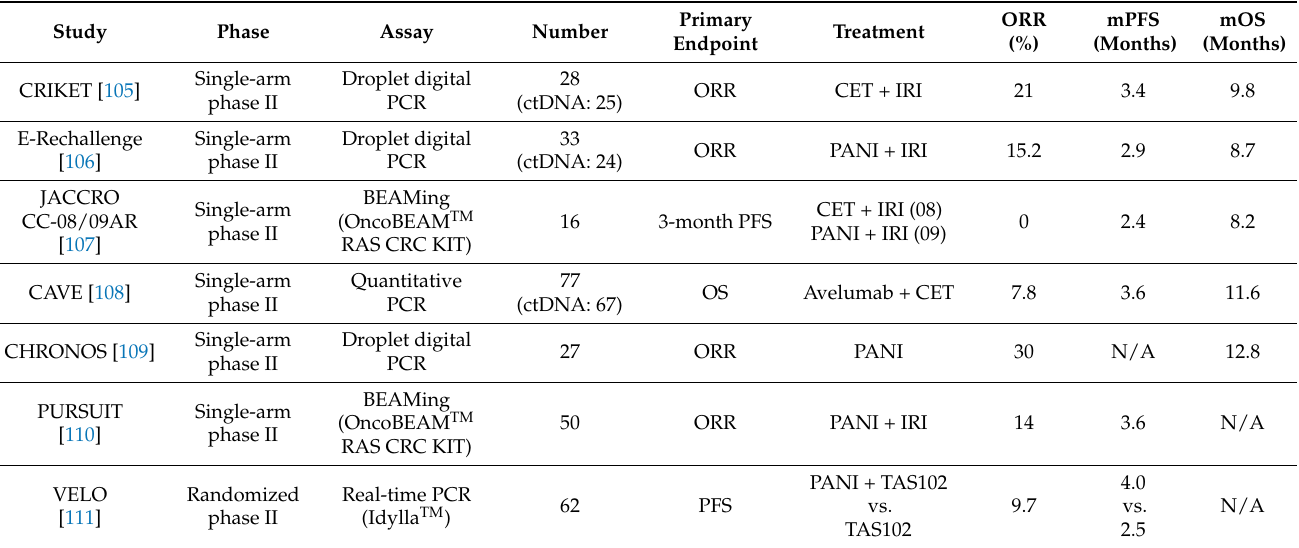
Table 1. Previous reports of anti-EGFR monoclonal antibody